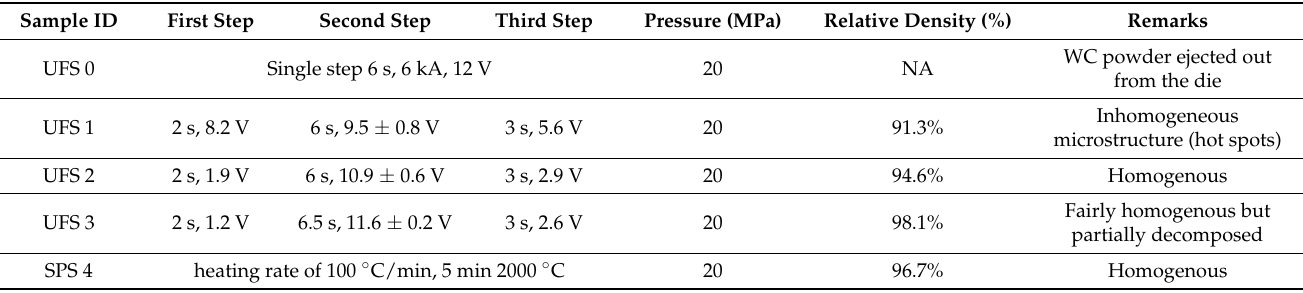
Table 1. Experimental parameters (current, time, average voltage) and obtained relative density. The recorded current for the second and third steps were 6 and 2.4